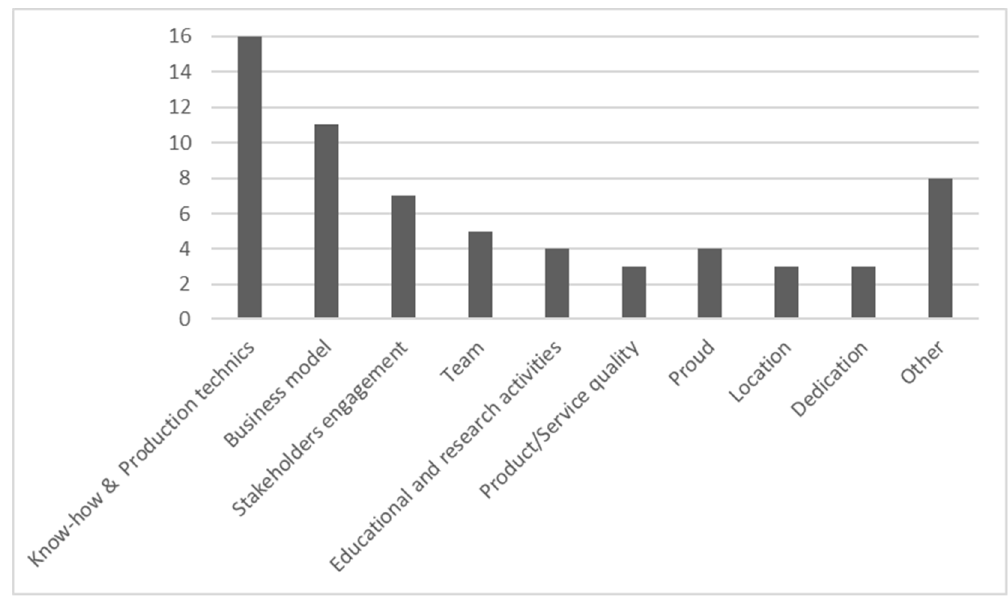
Figure 13. Number of respondents for the different success factors categories.